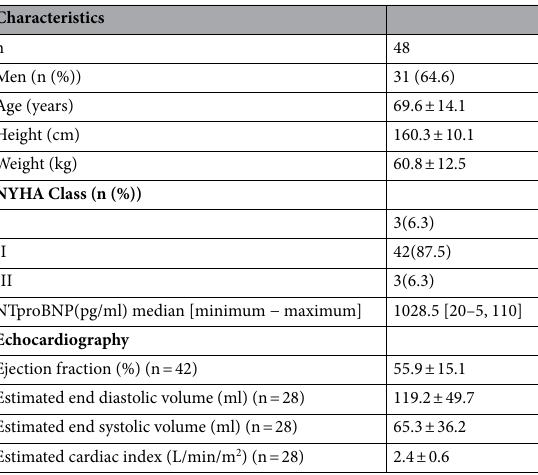
Table 2. Clinical characteristics of subjects. Values are mean ± SD, NYHA, New York Heart Association; NTproBNP, Nterminal pro-brain natriuretic peptide.